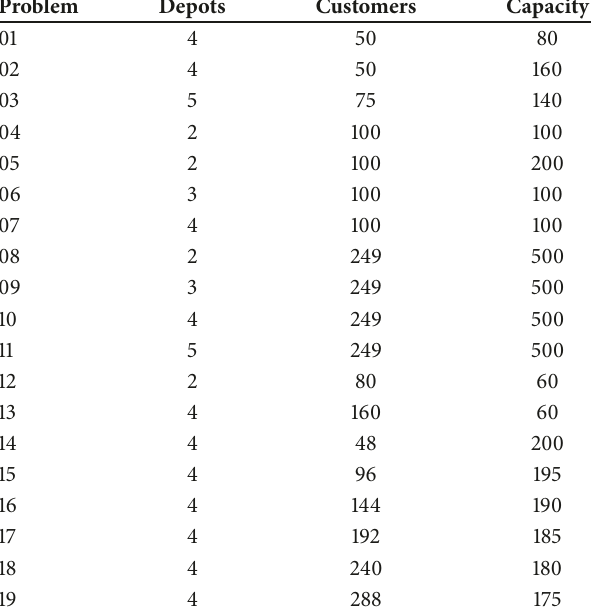
Table 1: The detailed information of data sets.